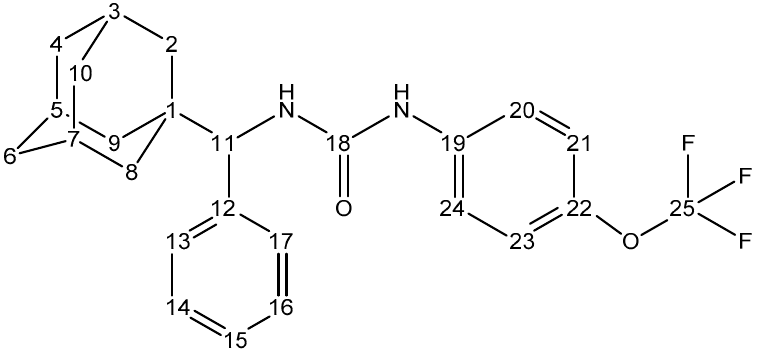
Atom labels for 13 C NMR presented on Figure 5.